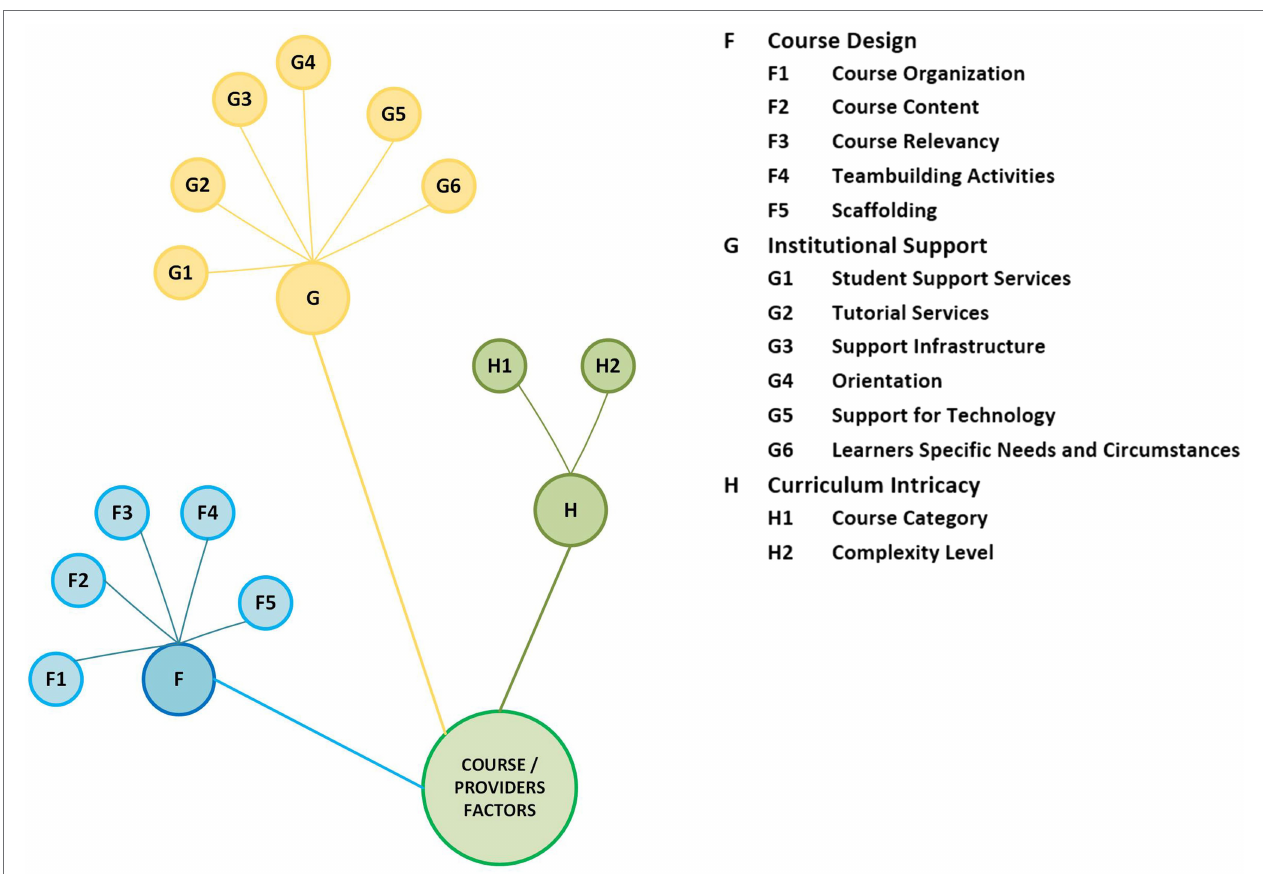
FIGURE 4 | Categorical arrangement of factors related to online courses and course